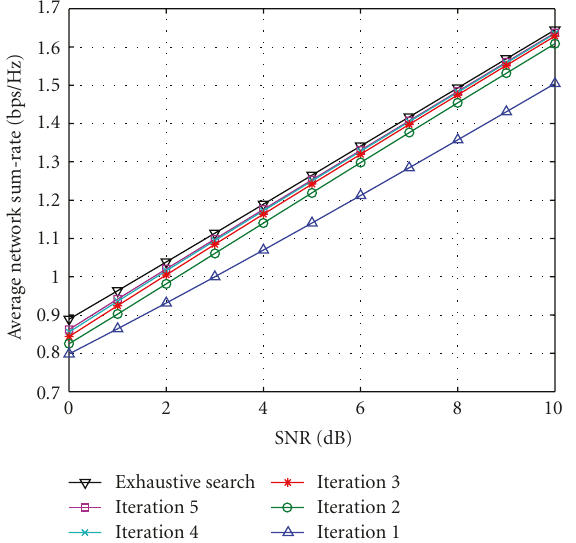
Figure 3: The convergence of the lower bound tightening (LBT) algorithm.